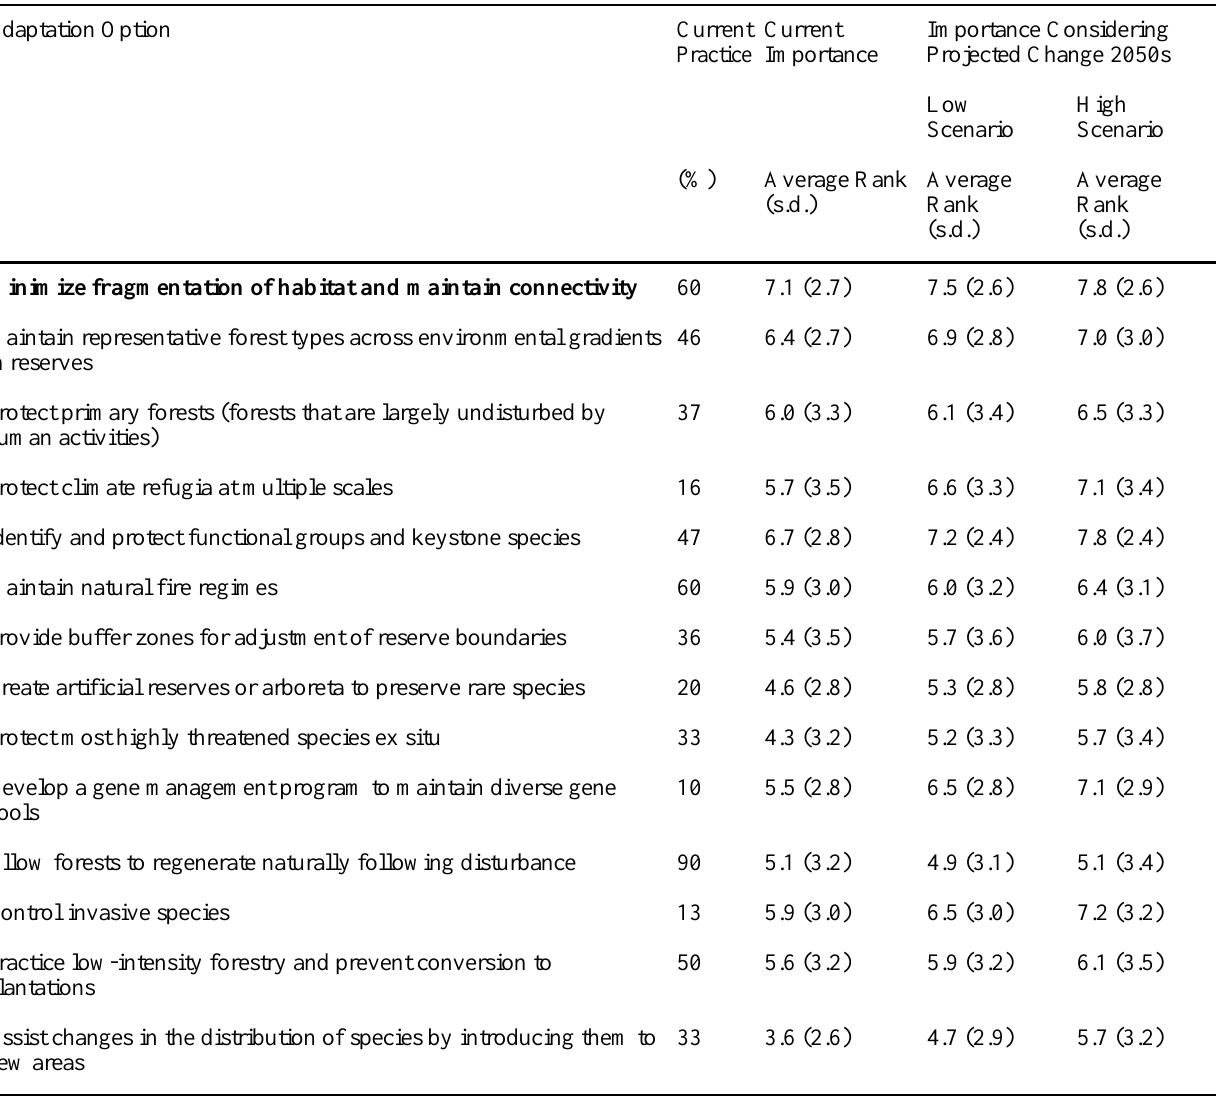
Table 4. Judgments of forest practitioners on the importance of adaptation options to conserve biological diversity in the Champagne and Aishihik Traditional Territory for each of three scenarios: “current climate conditions,” “low scenario of future climate change by the 2050s,” and “high scenario of future climate change by the 2050s.” Scale of 1 to 10 (0 = no importance, 1 = low importance, 10 = high importance) or don’t know. Results shown are the average rank and standard deviation (s.d.) of participants who provided a ranking. The percentage of participants who agree or strongly agree with the statement “this management option is currently being practiced in the Yukon” is also provided. Adaptation options in bold are considered to be “no-regrets” (option is ranked 7 or higher across range of